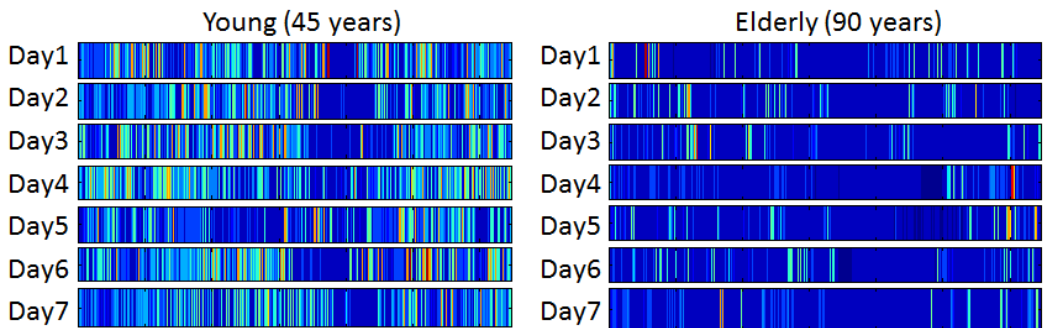
Figure 3. Examples of daily physical activity barcodes for a 45 years and a 90 years old participant. Dark blue colours are associated with lowest intensity activity states, and with warmer colours from green to yellow and read characterising higher intensity states. The red spectrum is associated with walking bouts at medium to high cadence.